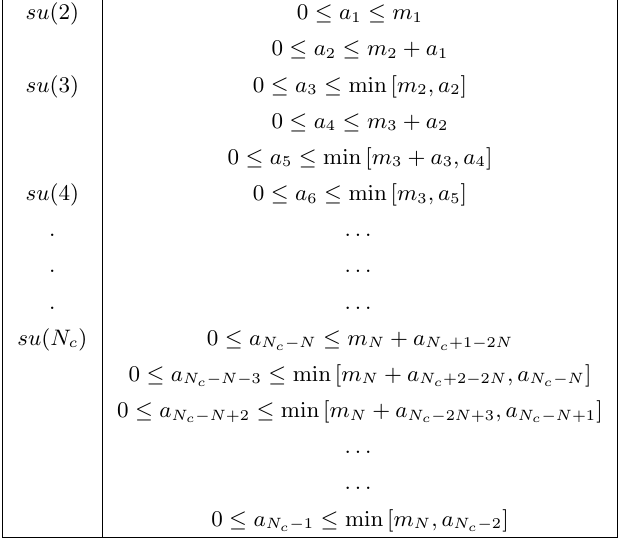
Table 11 . Verma bases inequalities